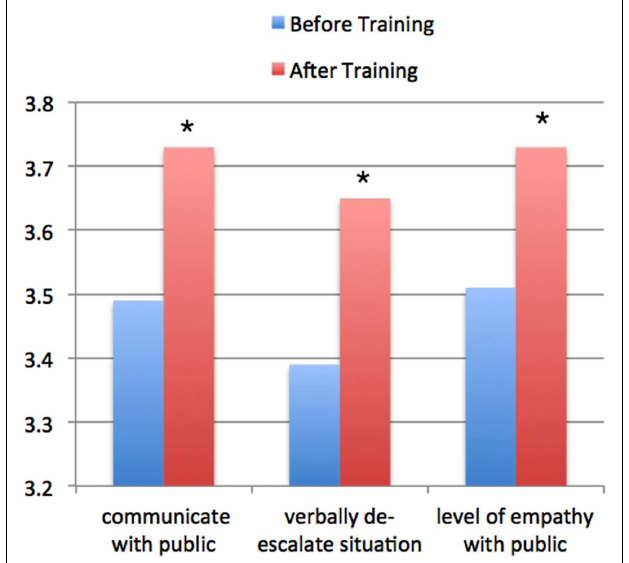
FIGURE 3 |This shows the data of observed behavior by the supervising officers of individuals ( n = 142) who provided feedback on individual officer ratings on the following three measures when interacting with individuals who potentially had a mental illness: the ability to communicate with the public, the ability to verbally de-escalate a situation, and their demonstrated level of empathy when interacting with the general public. Data are shown at “Baseline,” i.e., before police officers were trained, and 6months post-training.There were statistically significant differences on all three ratings (* p <